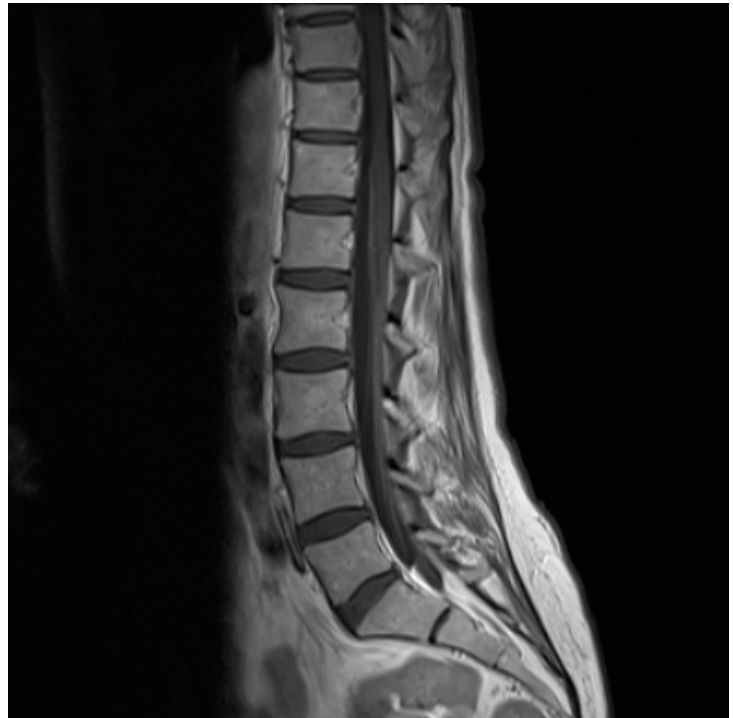
Figure 1. A 61-year-old female presented with opioid resistant radicular left-sided leg and back pains with nocturnal aggravation in July 2019. A year earlier she had been diagnosed with stage II breast cancer with lymph node metastasis. She had undergone lumpectomy with neoadjuvant chemotherapy, radiation and anti-estrogen treatment with letrozole. Initially, deep vein thrombosis was suspected; ultrasonic examination was performed, and anticoagulant therapy was initiated, as thrombosis could not be disproved. A skeletal scintigraphy conducted in the beginning of August was without evidence of bone metastases. Two weeks later the patient experienced progression of symptoms with band-shaped pain corresponding to Th8-10 and truncal dysesthesia, followed by unilateral foot drop and subsequent facial palsy, both right-sided. No cognitive deficiencies or nerve reflex abnormities were found. Under the suspicion of meningeal carcinomatosis, 150 mg prednisolone was initiated, and a magnetic resonance imaging (MRI) of the neuroaxis and a whole body 18 F-FDG PET / CT was requested and performed within the next 48 hours. Laboratory testing was within normal range. White blood cells were 6.8 × 10 9 / L (normal range: 3.5–8.8 × 10 9 / L), hemoglobin 8.7 mmol / L (normal range 7.3–9.5 mmol / L), C-reactive protein 2 mg / L (normal range: 0–10 mg / L). Additionally, alanine aminotransferase (ALT), lactate dehydrogenase (LDH), bilirubin and creatinine were normal. The patient did not recall tick-bite or erythema migrans. However, due to signs of radiculopathy and mononeuritis, cerebrospinal fluid (CSF) was tapped and examined for inflammatory and malignant cells. The analysis showed CSF pleocytosis with 106 cells per µ L (77% monocytes) and an elevated protein level of 1.14 g / L. CSF culture and polymerase chain reaction (PCR) for bacterial DNA in CSF were negative as well as PCR for herpes simplex virus, varicella zoster virus, enterovirus and cytomegalovirus. No malignant cells were detected in CSF, and flow cytometry was normal. The subsequent MRI showed a strong contrast enhancement of the conus medullaris.